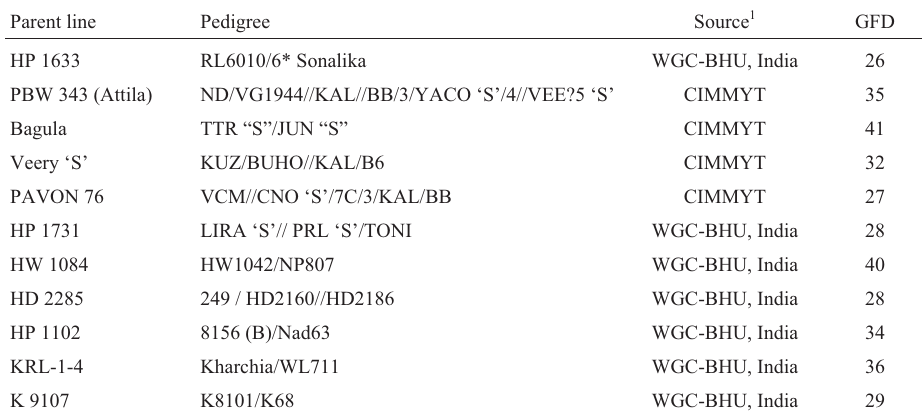
Table 1 - Pedigree of the parent wheat plants and their grain filling duration (GFD) periods in